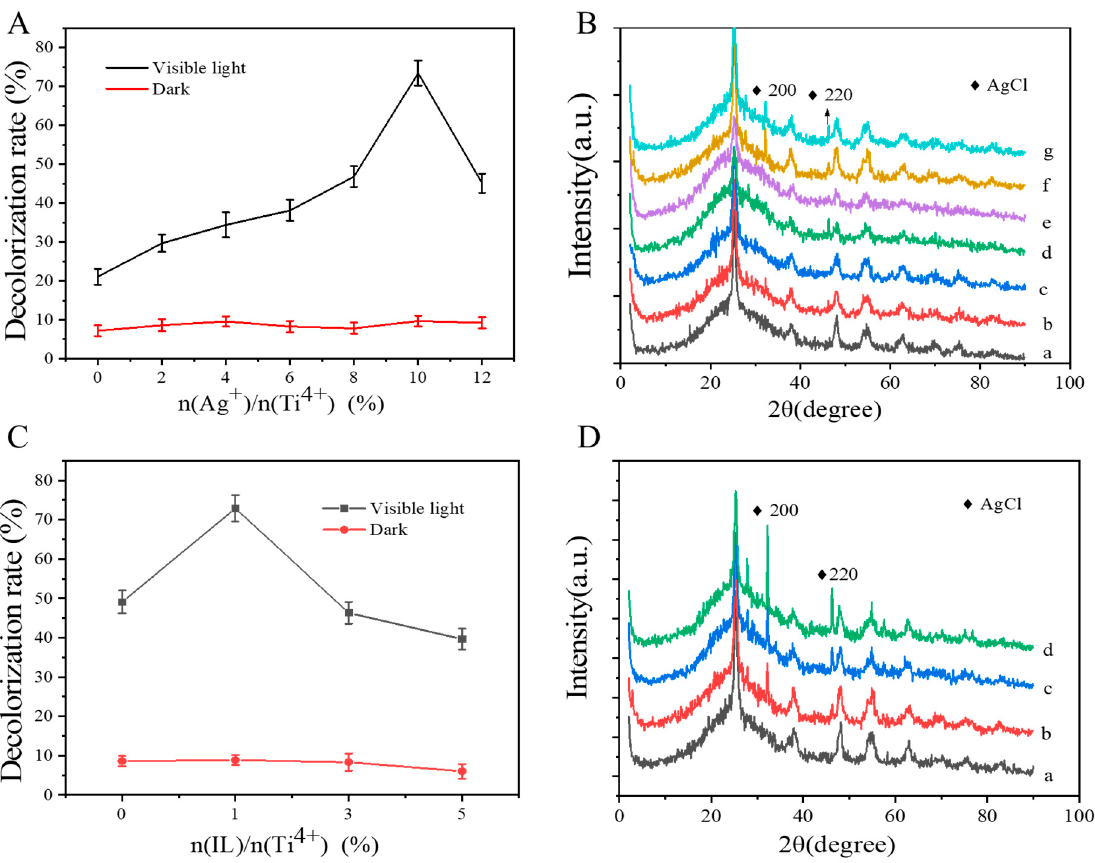
Figure 4. Visible light photocatalytic effect of Ag + ( A ) and ionic liquid ( C ) dosages during the TiO 2 /Ag[BMIM]Cl processing, XRD patterns of the TiO 2 /Ag[BMIM]Cl prepared at different amounts (( B ) from a to g n(Ag + )/n(Ti 4+ ) at 0%, 2%, 4%, 6%, 8%, 10%, 12%, IL: 1%; ( D ): from a to d n(IL)/n(Ti 4+ ) at 0%, 1%, 3%, 5%, Ag + : 10%).